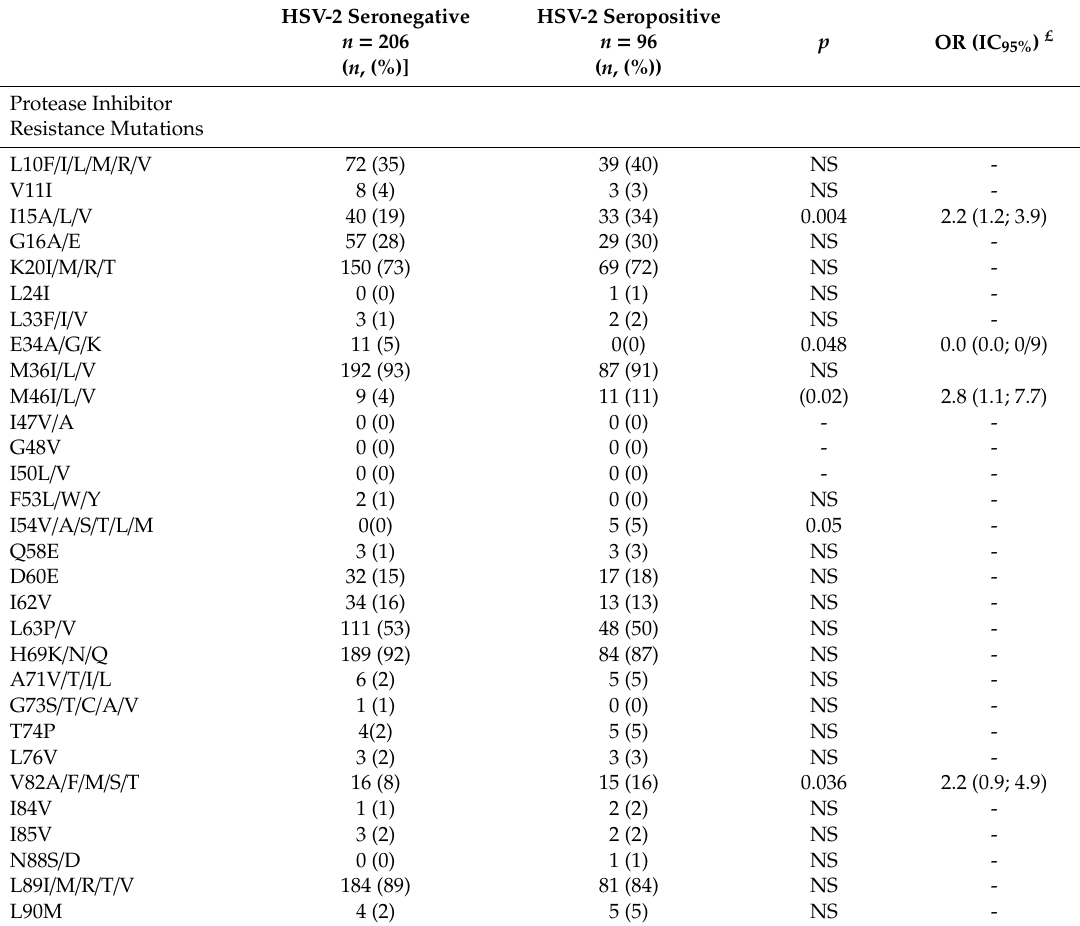
Table 4. HSV-2 seropositivity and selection of antiretroviral resistance mutations in the protease